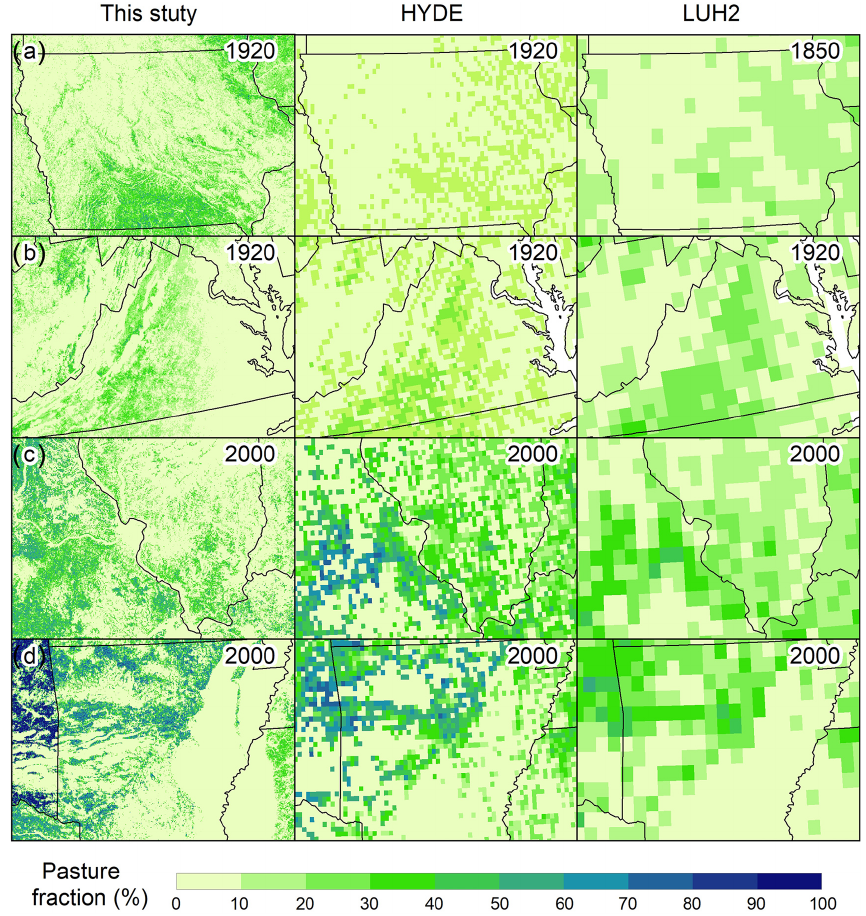
Figure 17. Visual comparison of our pasture data with History Database of Global Environment (HYDE) and Land Use Harmonization (LUH2) in four different sites (a–d) . The locations of image center points are as follows: (a) Iowa (93.64 ◦ W, 42.03 ◦ N), (b) Virginia